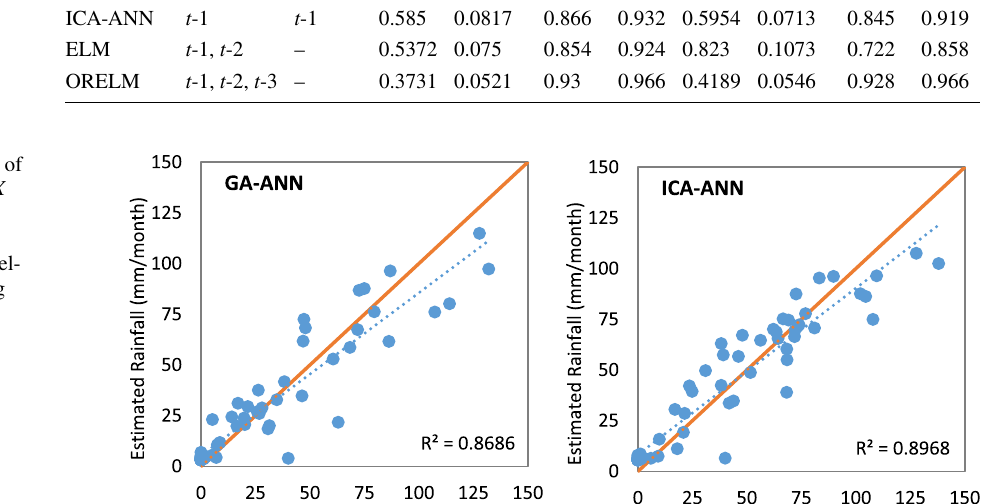
Table 1 performance evaluation of GA-ANN, ICA-ANN, ELM and ORELM models in predicting GWL based on statistical indices in the train and test stages